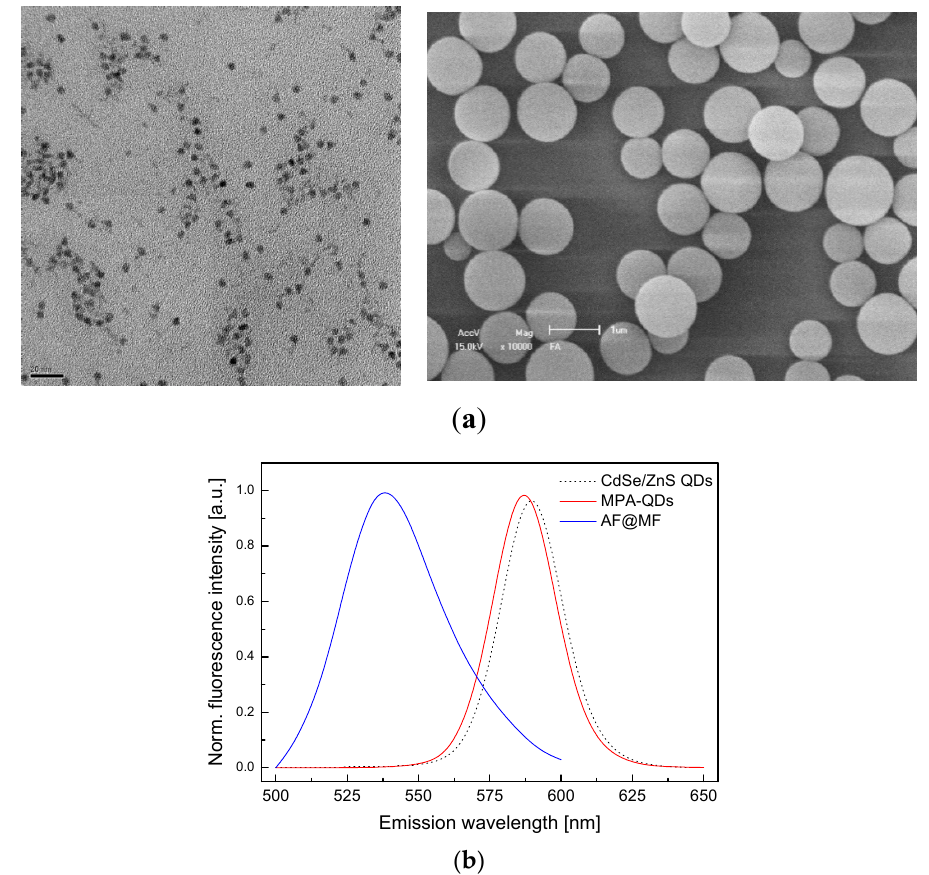
Figure 1. ( a ) TEM images of CdSe/ZnS quantum dots (QDs) (left, scale bar = 20 nm) and aminofluorescein-encapsulated melamine-formaldehyde (AF@MF) particles (right, scale bar = 1 µm). ( b ) Fluorescence emission spectra of CdSe/ZnS QDs, hydrophilic CdSe/ZnS QDs (mercaptopropionic acid-coated QDs (MPA-QDs)), and AF@MF particles.